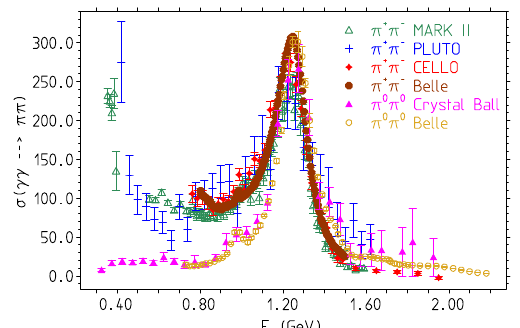
Fig. 2 How do photons couple to pions? This is obviously probed in reactions like γγ → π + π − ,π 0 π 0 . One can infer from data that below about 1 GeV photons couple to pions as point-like objects (i.e. only the charged pions are produced directly). At higher energies, the photons see the quarks exclusively and form the prominent tensor resonance f 2 ( 1270 ) . The π 0 π 0 cross section in this figure is enhanced by the